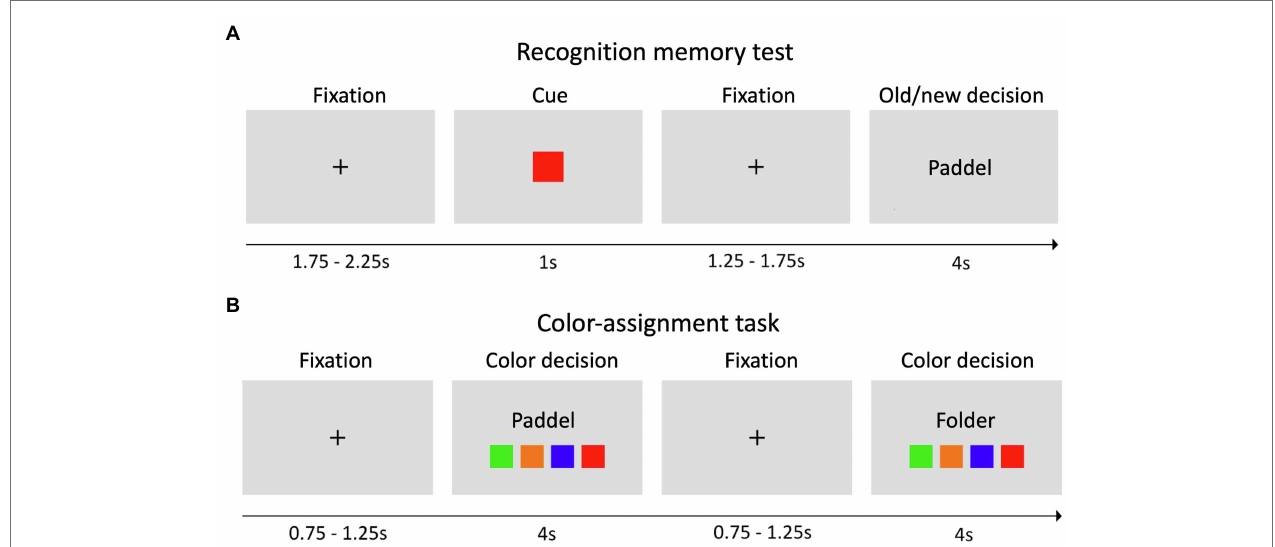
FIGURE 1 | Experimental paradigm. (A) In the recognition memory test, each trial started with a fixation cross, followed by a colored cue, a fixation cross, and an old or new word. Old words were always from the corresponding color list, as indicated by the cue, and participants were asked to consider this information to solve the task. For each presented word, subjects had 4 s to indicate whether they recognized the word (old) or not (new) via button press. (B) In the color-assignment task, subjects were presented only with old words and had to identify the color list, from which the word was